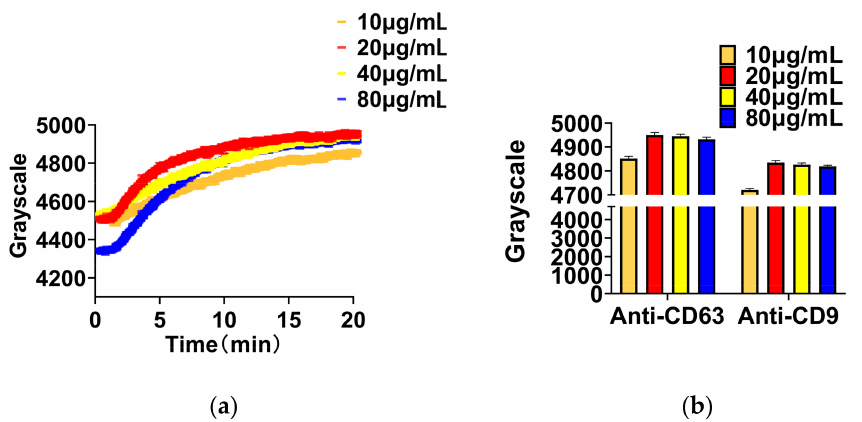
Figure 3. Detection of different concentrations of antibody by TIRIE. ( a ) Four real-time curves for the interaction between protein G and anti-CD9/anti-CD63 in four concentrations, respectively. ( b ) The sensing signal of four different concentrations of anti-CD9 and